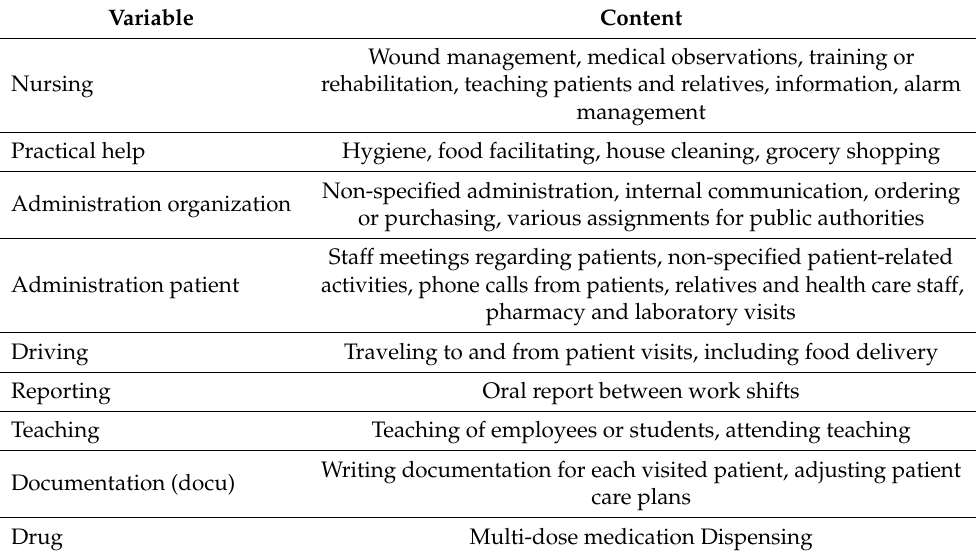
Table 1. Individual activities and their corresponding clustered activity